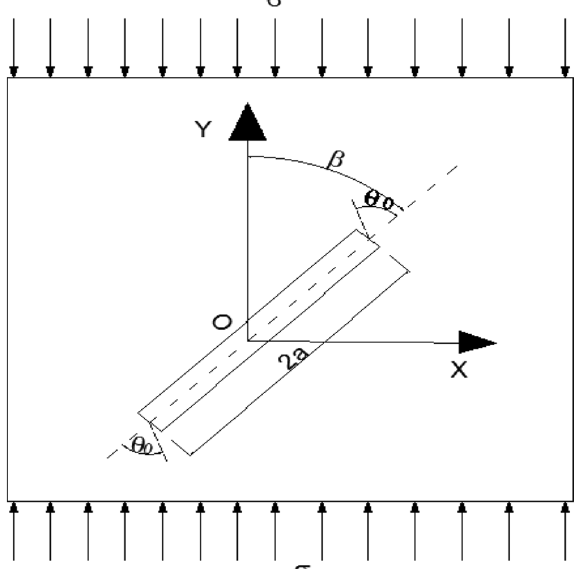
Figure 19. Schematic diagram of a single microcrack subjected to uniaxial compression